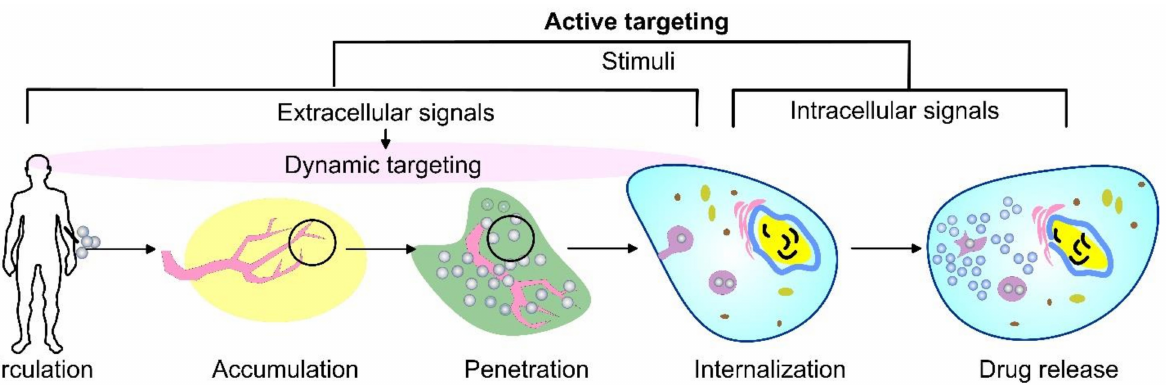
Figure 1. Surface modification strategies of liposomes, together with their classification. The modified carriers can contain active components, such as drugs, small molecules, proteins, and/or targeting moieties, such as antibodies, peptides, aptamers, etc., conjugated on the surface of the vehicles through different linkers, non-covalent or covalent bonds, and electrostatic interactions. Abbreviation: PL—phospholipid.